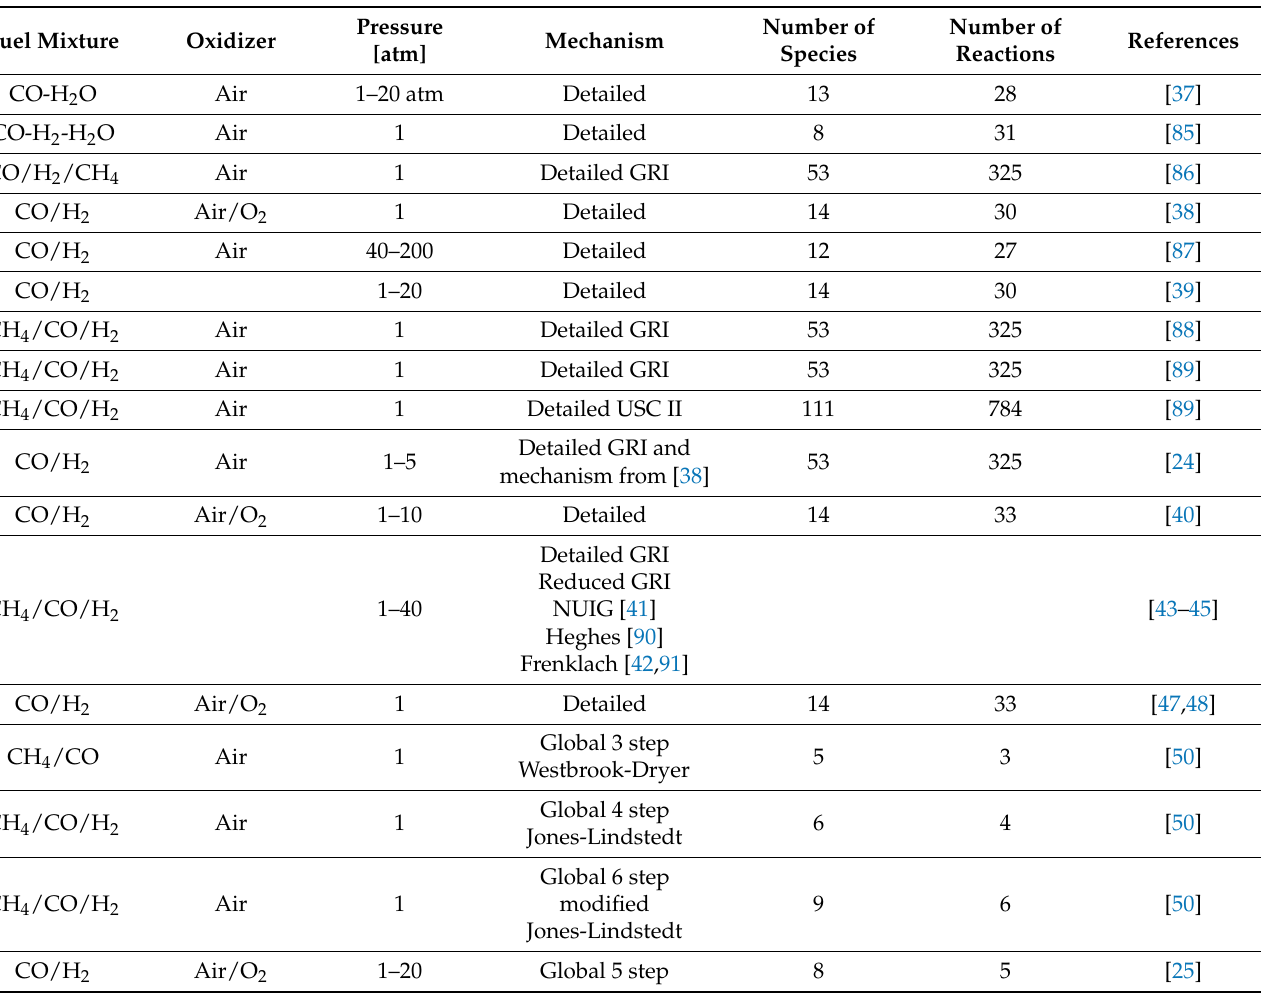
Table A1. Summary of utilized mechanisms for different reactive flow modelling.